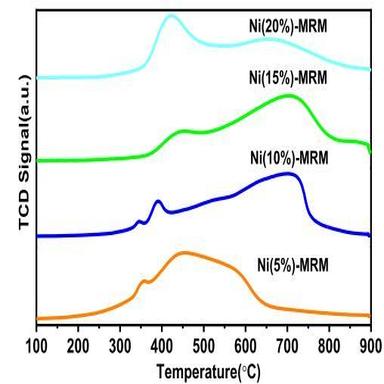
H2-TPR profile of Ni-MRM materials with various Ni loading.